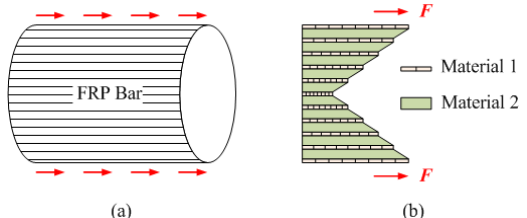
Figure 2. Shear-lag phenomenon: ( a ) overview; and ( b ) longitudinal section.